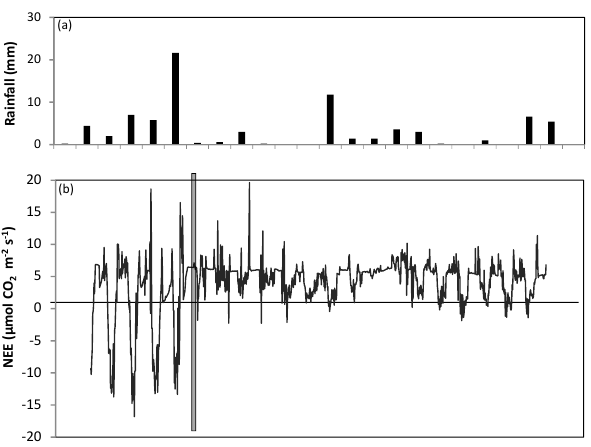
Figure 3. (a) Daily precipitation and (b) diurnal patterns of NEE at the CS site for the week prior to the clearing event of 2– 6 March 2012 (vertical bar) and 3 weeks